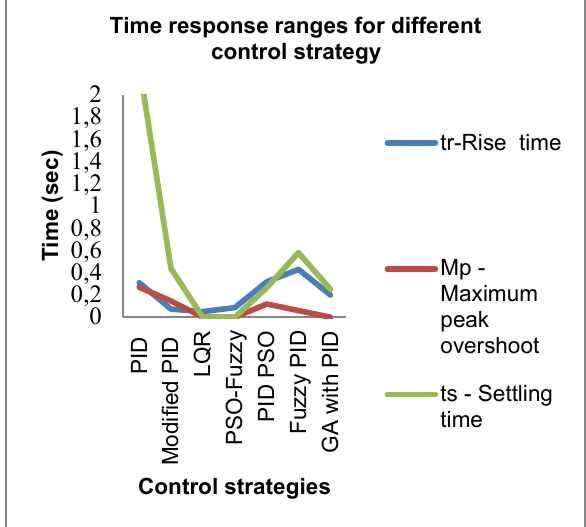
Figure 3. Comparison on control strategies with transient response of DC motors (as per literature)